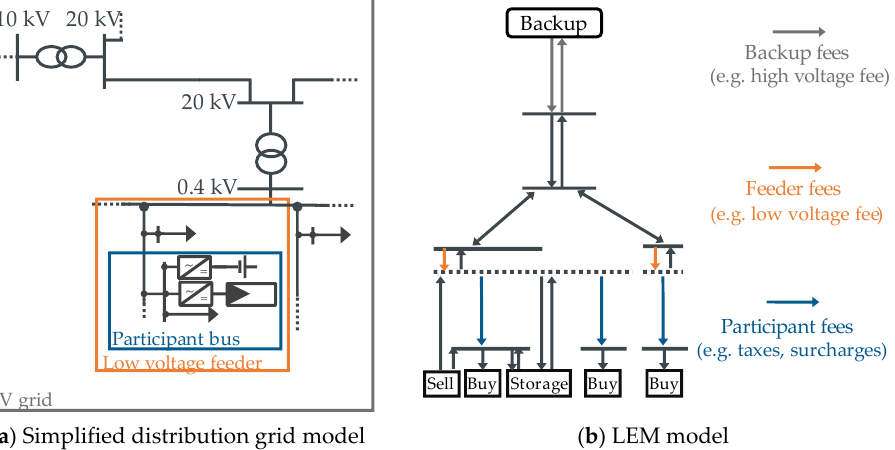
Figure 2. Modeling simplification of distribution grid topology ( a ) within the LEM market matching model ( b ).